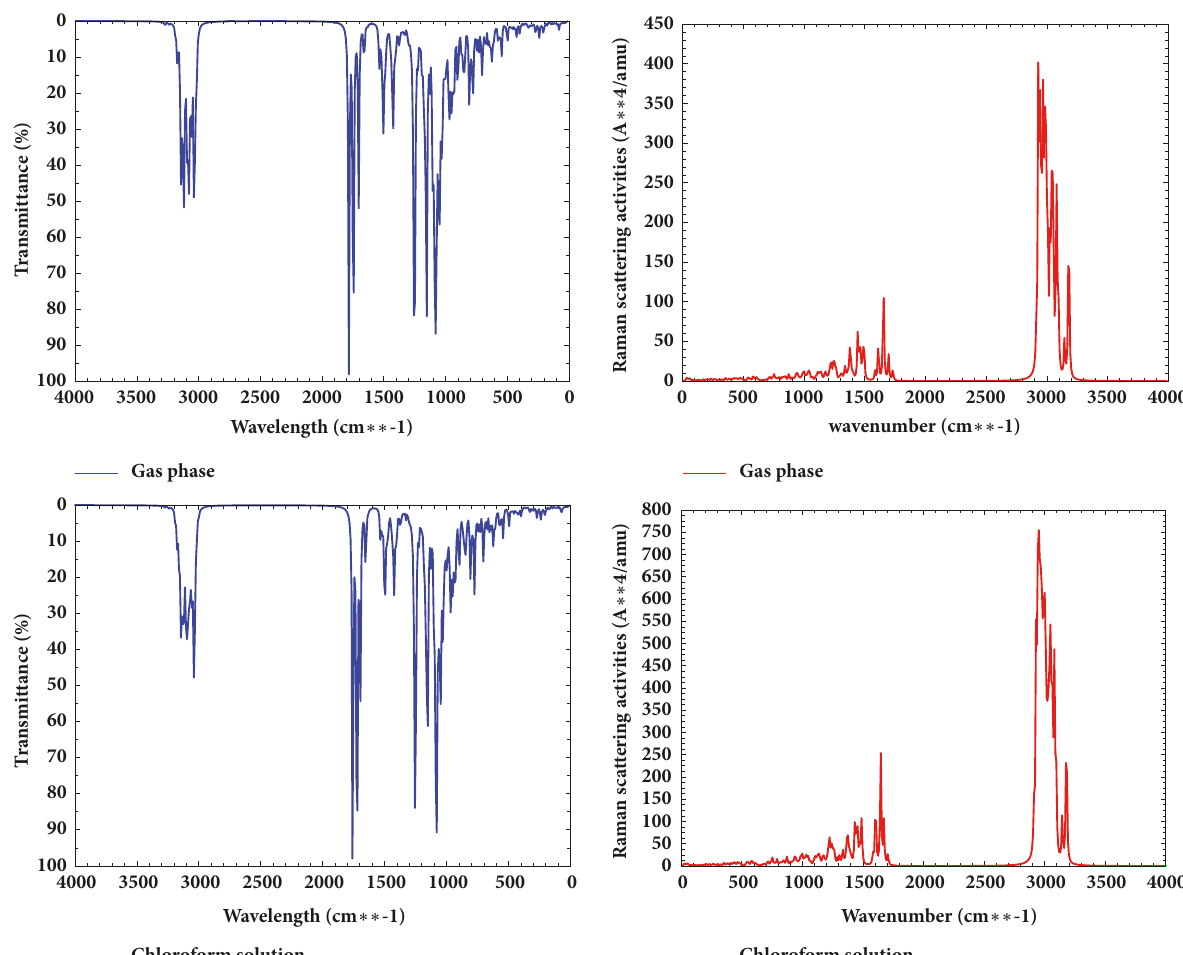
Figure 8: IR spectra (blue) and Raman spectra (red) of Rubescin E in both gas phase (top) and chloroform solution (bottom) using B3LYP/6-